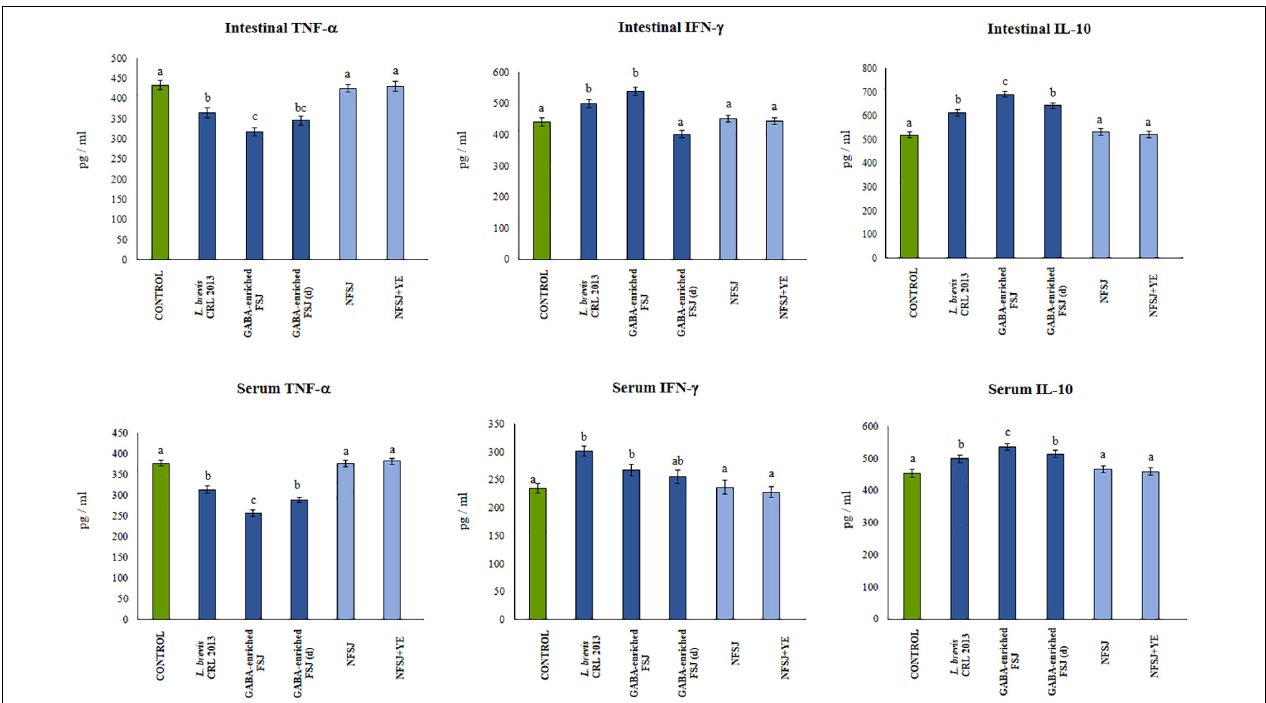
FIGURE 6 | Effect of L. brevis CRL 2013, GABA-enriched strawberry fermented juice (FSJ) and diluted (d) GABA-enriched FSJ on intestinal and serum cytokines and chemokines in mice challenged with LPS. Animals treated with NFSJ or NFSJ supplemented with YE were used for comparisons. Results are expressed as mean ± SD. Means for each bar without a common letter differ significantly. Significance with Tukey’s HSD post hoc test following a one-way ANOVA is indicated as p < 0.05.